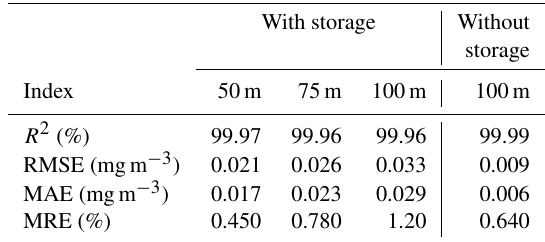
Table 3. Error indices of verification by the analytical solution for continuous boundary condition.